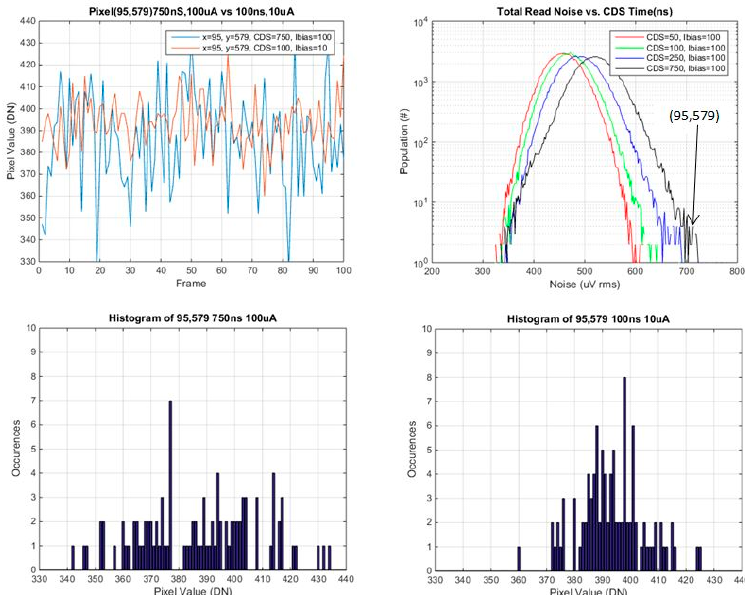
Figure 14. Pixel value vs. frame, and histogram of pixel values for pixel 95,579 (from the tail of the noise histogram).